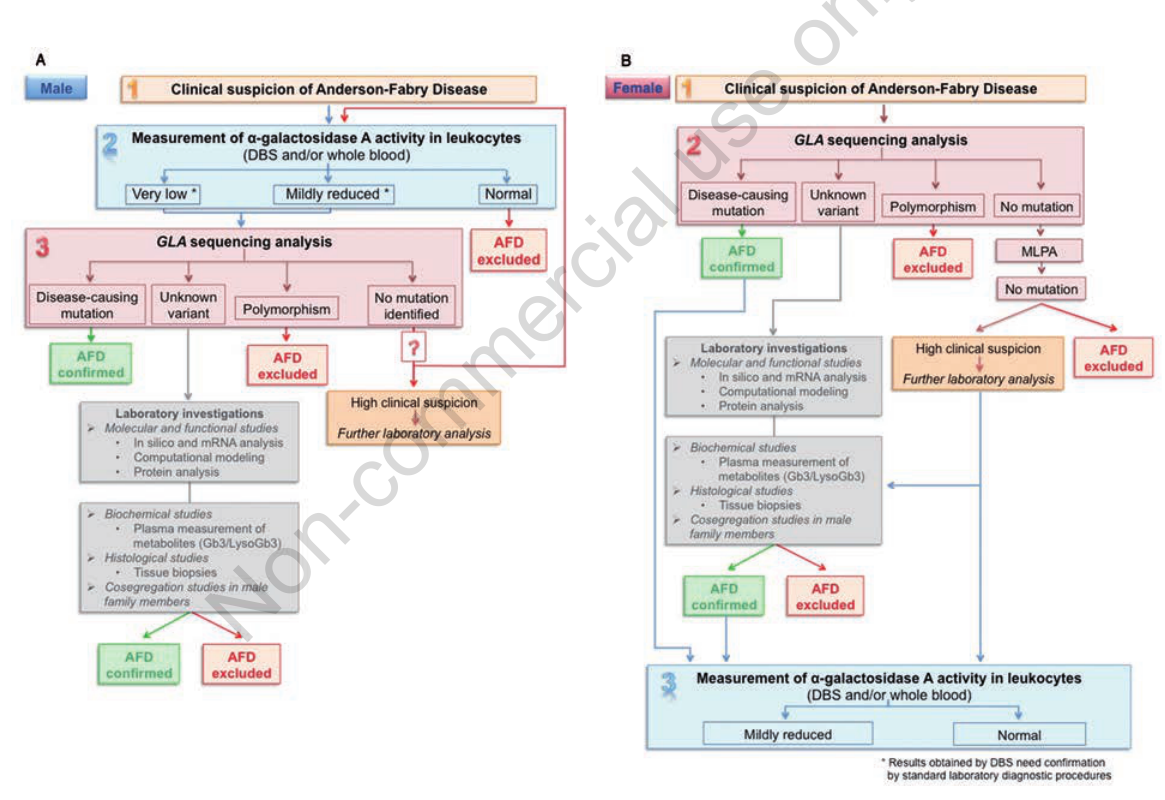
Figure 11. Diagnostic flow chart of Anderson-Fabry disease (AFD) in males and females: step-by-step approach. Panel A) males. 1) Clinical picture indicative of AFD, family history compatible with an X-linked transmission. 2) In males, normal values of a -gal A activ- ity exclude the diagnosis of AFD. Reduced (<20%) or absent enzyme activity values confirm the suspicion of AFD and require genetic testing. Biochemical analysis on dried blood spot (DBS) must be confirmed by standard laboratory procedures ( i.e. whole blood analy- sis). 3) If no mutations are identified by genetic analysis, and the a -gal A activity is low or undetectable, further laboratory analyses are required to confirm the diagnosis ( e.g. mRNA and protein analysis, tissue biopsies). Comparably, the identification of new unknown variant requires laboratory analysis, along with co-segregation studies within the family. Panel B) females. 1) Clinical picture indicative of AFD, family history compatible with an X-linked transmission. 2) In female the a -gal A activity can be within the normal range. Therefore genetic analysis is mandatory to confirm the diagnosis; if no mutations are identified by genetic analysis, and the clinical sus- picion is high, further laboratory analyses are needed ( e.g. multiplex ligation-dependent probe amplification to detect deletions or inser- tions, mRNA and protein analysis, tissue biopsies). Comparably, the identification of new unknown variant requires laboratory analy- sis, along with co-segregation studies within the family. 3) Enzyme activity may be helpful in diagnosis and management of female AFD patients and should be measured after the genetic diagnosis is made. Biochemical analysis on DBS must be confirmed by standard lab- oratory procedures ( i.e. whole blood